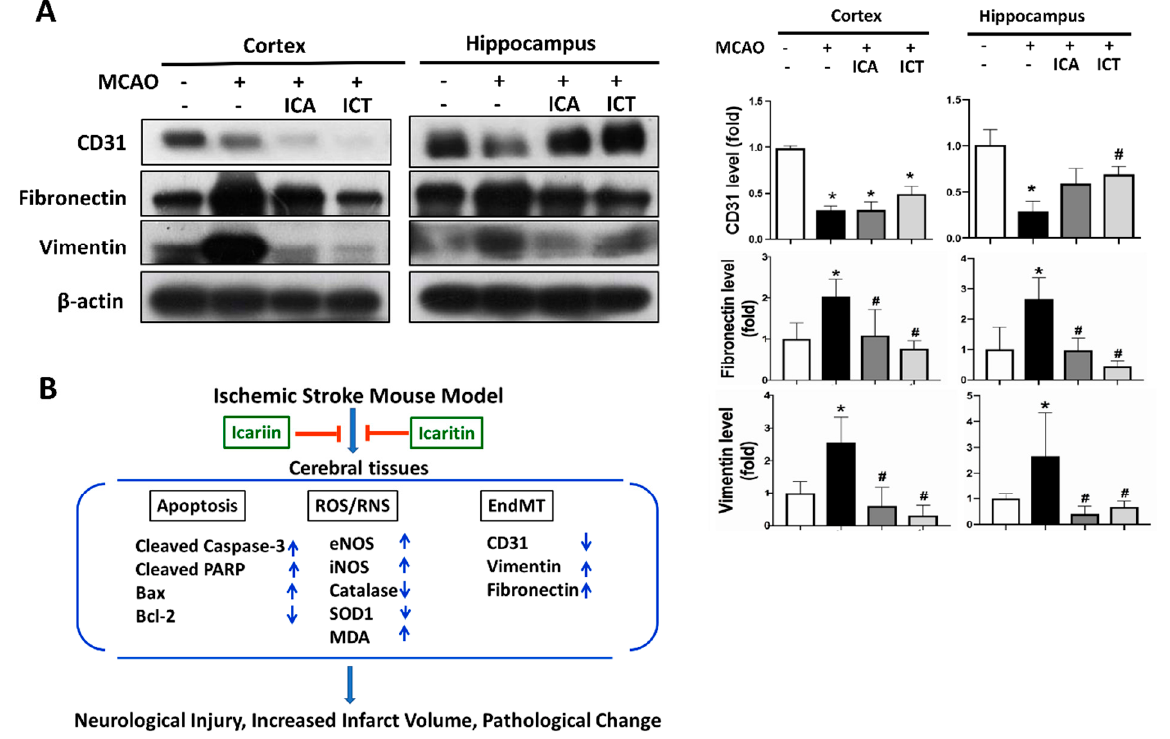
Figure 6. Both ICA and ICT treatment reduced endothelial-to-mesenchymal transition and extracellular matrix accumulation in the left cerebral hemisphere tissues of mice with acute cerebral ischemia–reperfusion. ( A ) The levels of protein expression for CD31 (endothelial marker) and fibronectin and vimentin (fibroblast markers) in the hippocampus and cortex tissues were determined by Western blot. The quantification of protein expression was determined by densitometry. Data are presented as mean ± SD ( n ≥ 4). * p < 0.05 compared to sham group; # p < 0.05 compared to MCAO group. ( B ) A schematic summary of our main findings for the effects of both ICA and ICT on the acute cerebral ischemia–reperfusion injury is shown.